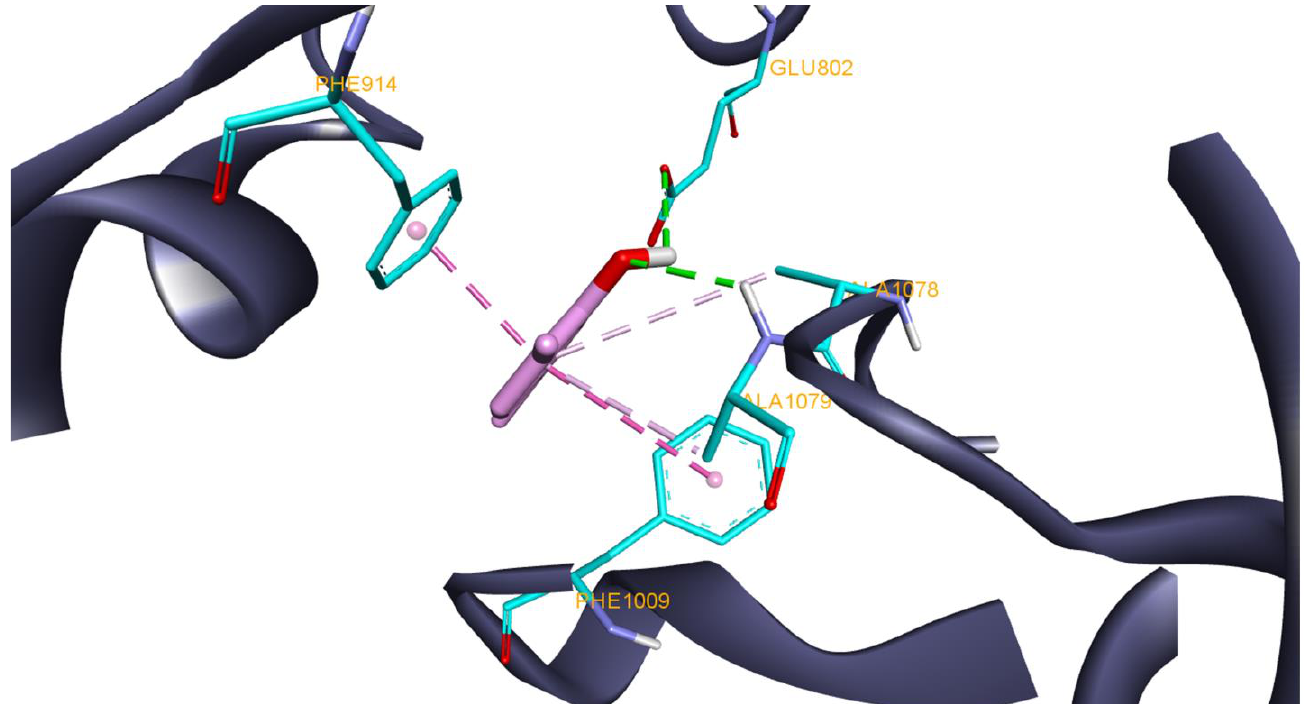
Figure 6. Structure of xanthine oxidase (3NRZ) in complex with docked compound 26 (carvacrol) interacting with highlighted amino acids (cyan) Glu802, Phe914, Phe1009, Ala1078 and Ala1079; HB interactions are depicted as green dotted lines and hydrophobic interactions as purple dotted lines.